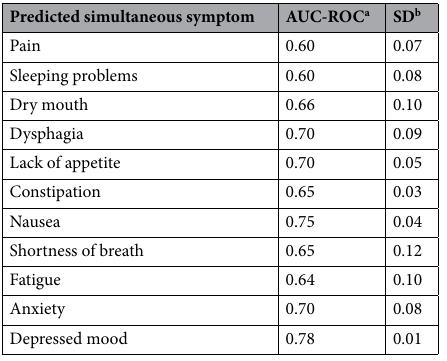
Table3. Predictive performance of the Bayesian network model per symptom, as measured by the mean area under the receiver operating curve calculated using fourfold cross-validation. AUC-ROC Area under the receiver operating curve, SD standard deviation. a Mean AUC-ROC of fourfold cross-validation. b Mean SD of fourfold cross-validation.